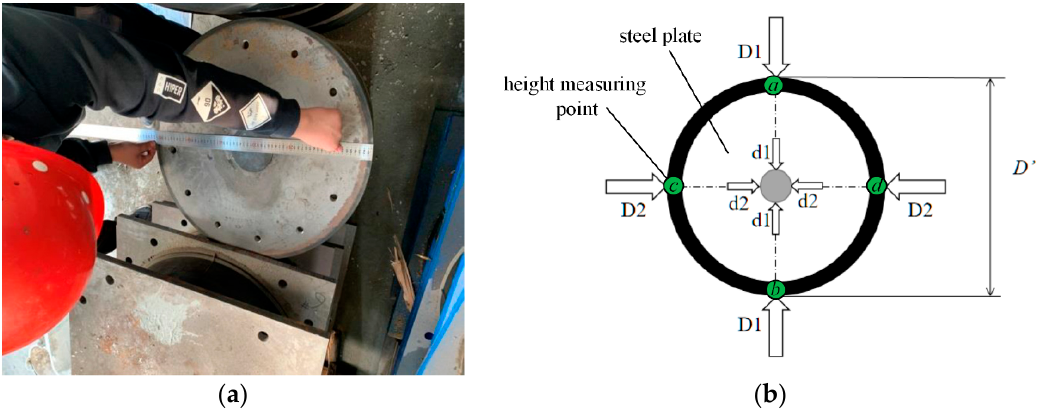
Figure 3. Measure of the specimens before the test: ( a ) photo; ( b ) measure points. Table 2. Measured geometry of the